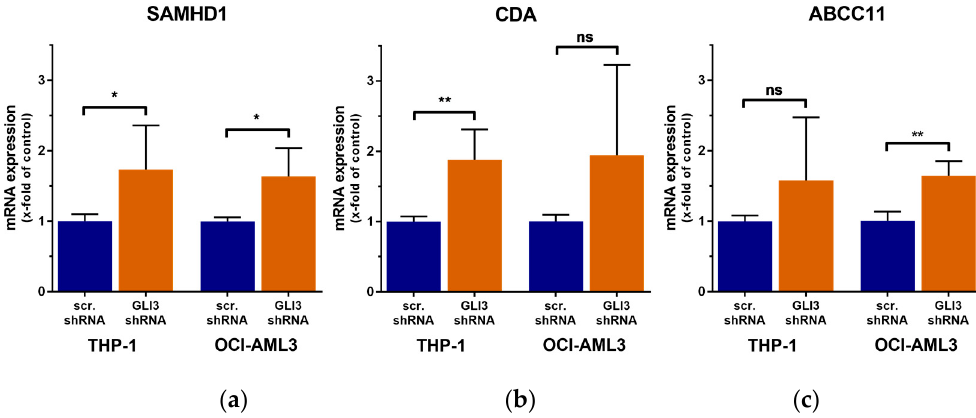
Figure 6. Knockdown of GLI3 results in the upregulation of genes involved in Ara-C metabolism and transport. Expression levels of SAMHD1 ( a ), CDA ( b ), and ABCC11 ( c ) in GLI3-knockdown cell lines THP-1 and OCI-AML3 were quantified by RT-qPCR and compared to their expression levels in control cells transduced with a scrambled shRNA. Error bars represent the mean values ± standard deviation; * p < 0.05, ** p < 0.01 in the Welch’s t -test; ns, not significant.